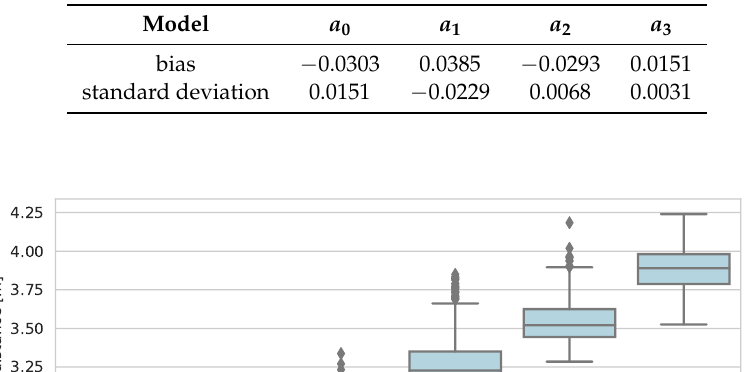
Table 2. The bias and standard deviation models coefficients.